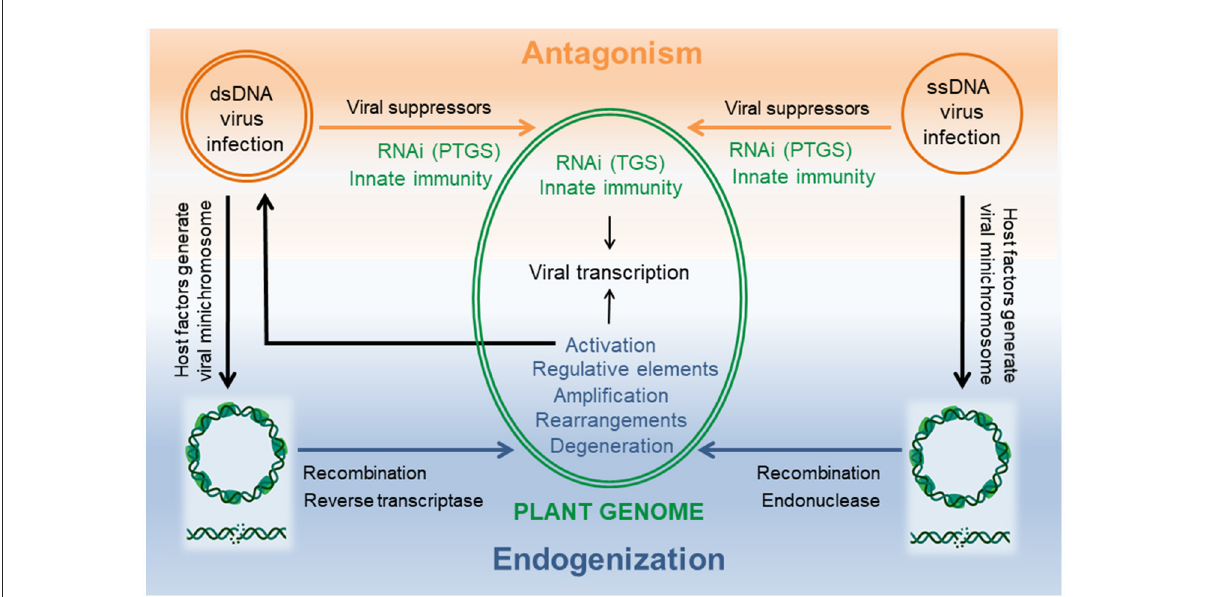
FIGURE1 DNA viruses and host plant interactions from antagonism to endogenization. Successful viral infection is established when viral suppressors can overcome the host cellular defense machinery consisting of RNAi and innate immunity. Multiple levels of interactions in the nucleus as well as in the cytoplasm are possible during this arms race. Common to both viruses is a viral minichromosome that is generated using host factors and serves as template for viral transcription in the nucleus. Double strand DNA breaks result in linearized molecules that can promote endogenization by illegitimate recombination and/or interference with reverse trancriptase (dsDNA viruses) or endonuclease (ssDNA viruses). Evolution of the chimeric host-virus genome can create diversity by rearrangements, insertion of viral regulative elements, amplification and/or degeneration of virus sequences. Integrants that allow transcription of a genome length RNA are the source for virus replication and systemic infection. Minichromosomes and dsDNA breaks created with